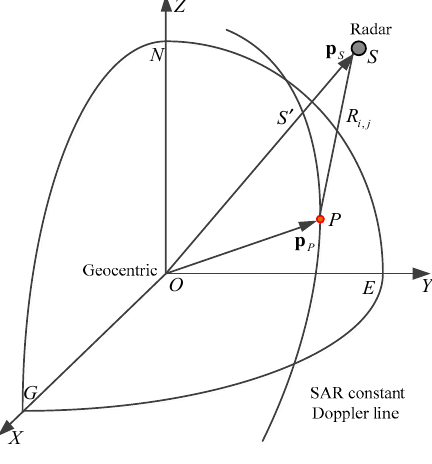
Figure 6. ECR coordinate system.